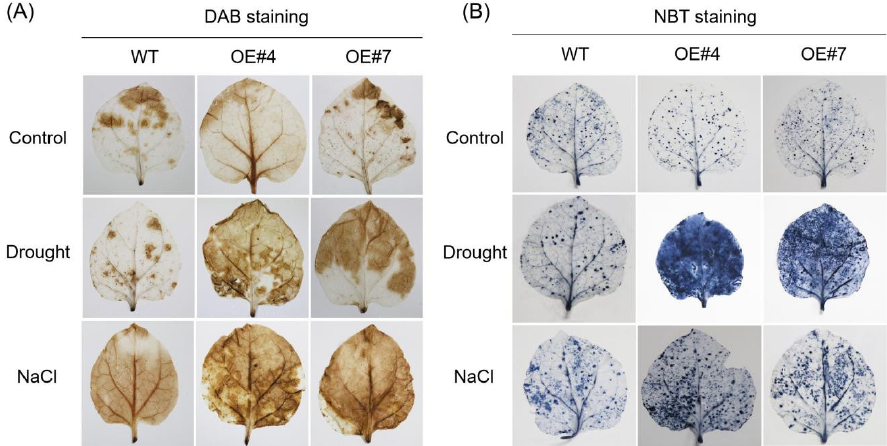
Figure 5. Overexpression GmPUB21 increases ROS accumulation under drought and salt stress. ( A ) Histochemical analysis of H 2 O 2 by DAB staining and ( B ) analysis of O 2- by NBT staining. The 4- week-old transgenic and WT tobacco plants were subjected to drought stress or salt stress (250 mM NaCl) for 3 days and then leaves were collected and analysed for ROS accumulation. The experi- ments were repeated three times and similar results were obtained. 2.5. The Stable Genetic Transformation of GmPUB21 Promoted Its Expression in Guard Cells and Increased Stomatal Density OE-GmPUB21 plants were sensitive to drought and salinity stress, leading us to won- der what the difference between transgenic plants and wild-type plants is. Interestingly,